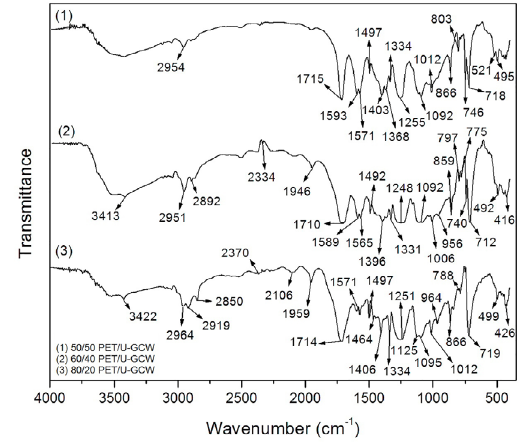
Figure 3. Overlay of the FT-IR spectra for the PET/U-GCW composites.